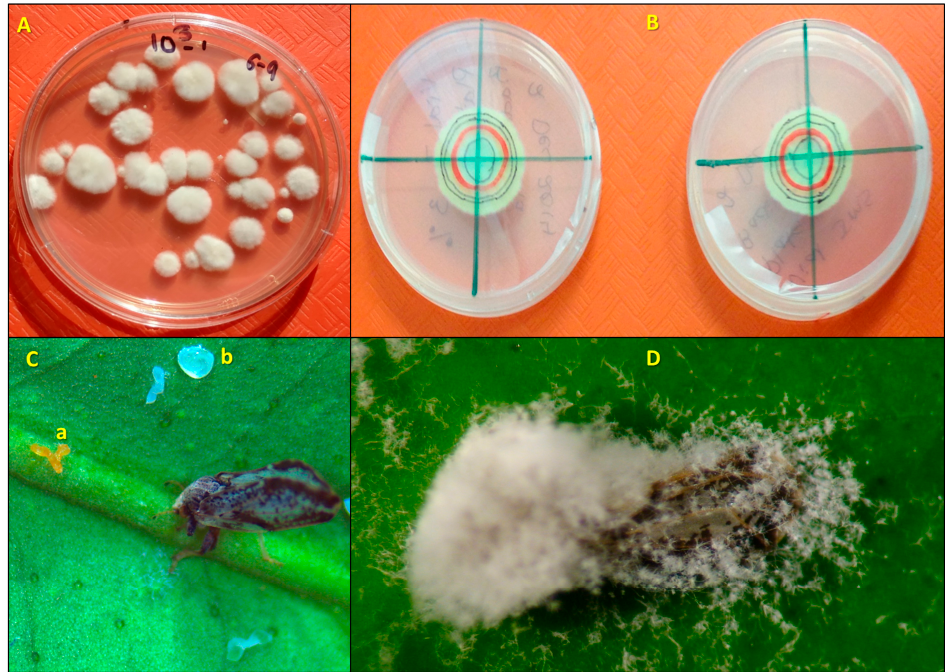
Figure 1. Viability and infection parameters of Isaria fumosorosea on the Asian citrus psyllid, Diaphorina citri alone and after being mixed with horticultural mineral oil (HMO) treatments: ( A ) I. fumosorosea CFUs growing on potato dextrose agar; ( B ) radial growth of I. fumosorosea with HMO (left) compared to control (right); ( C ) D. citri adult previously having fed on the midrib vein of a citrus leaf disk inside of the bioassay chamber, which is now dead, infected with I. fumosorosea and attached to the leaf by the fungus growing through the tarsi; ( a ) eggs laid previous to adult psyllid death are now infected; ( b ) honeydew droplet deposited after feeding inside bioassay chamber; ( D ) Colonization of adult D. citri by fungus and production of conidia on the phialides extending away from the infected wings onto the leaf; note the fungus horizontal growth from the mycosed insect into the surrounding area.